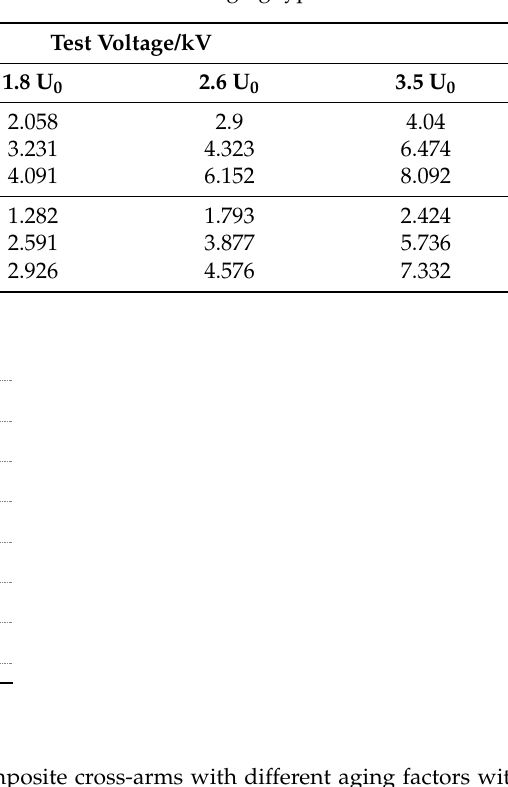
Table 6. Leakage current of the composite cross-arms with different aging types.